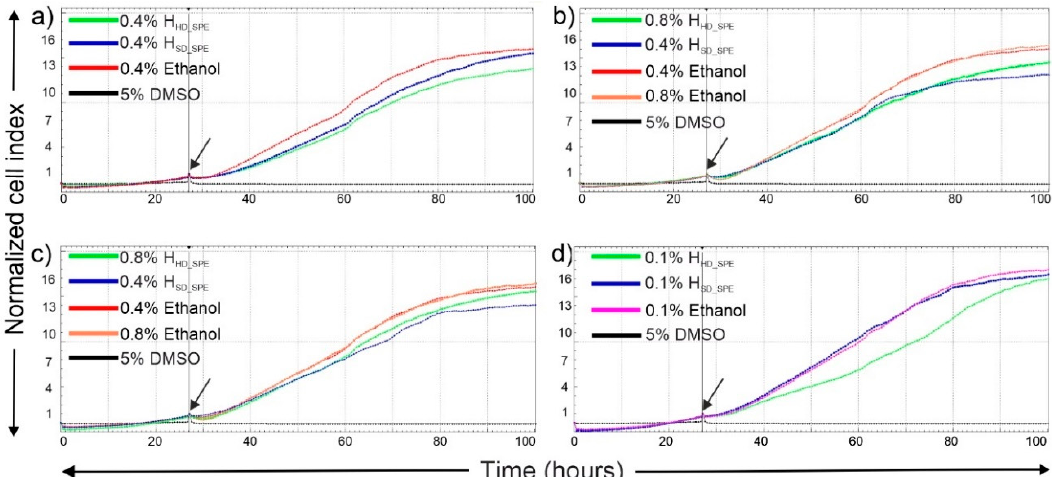
Figure 2. Dynamic monitoring of cytotoxic response to different concentrations of the hydrolates concentrated by SPE. A549 cells were treated with selected concentrations of ( a ) lavender, ( b ) fennel, ( c ) bay leaves and ( d ) clove concentrated hydrolates. Cells treated with 0.1%, 0.4% and 0.8% ethanol were used as vehicle control and 5% DMSO treated cells were as positive control. Arrow showing time-point of treatment. Cell index values over 72 consecutive treatment hours were normalized to the time point of treatment.